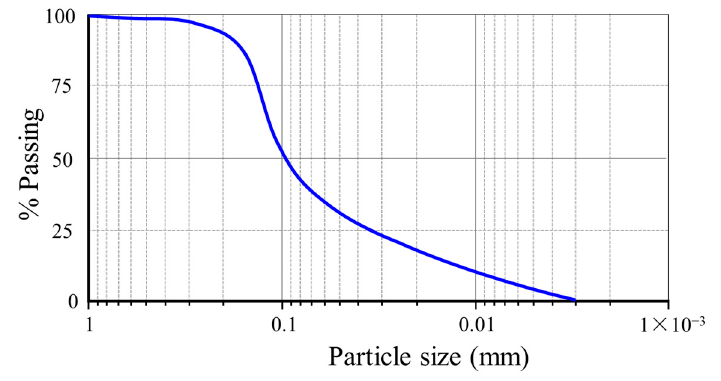
Figure 1. Particle size analysis of sandy silt.